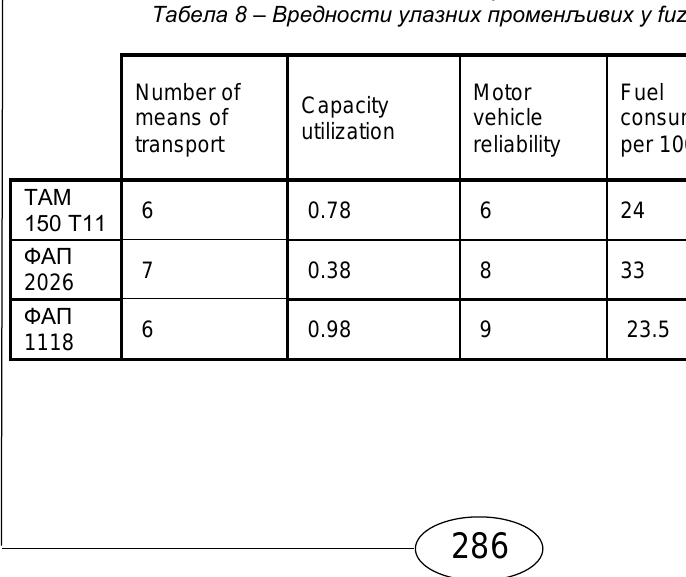
Table 8 – Values of the input variables in the fuzzy